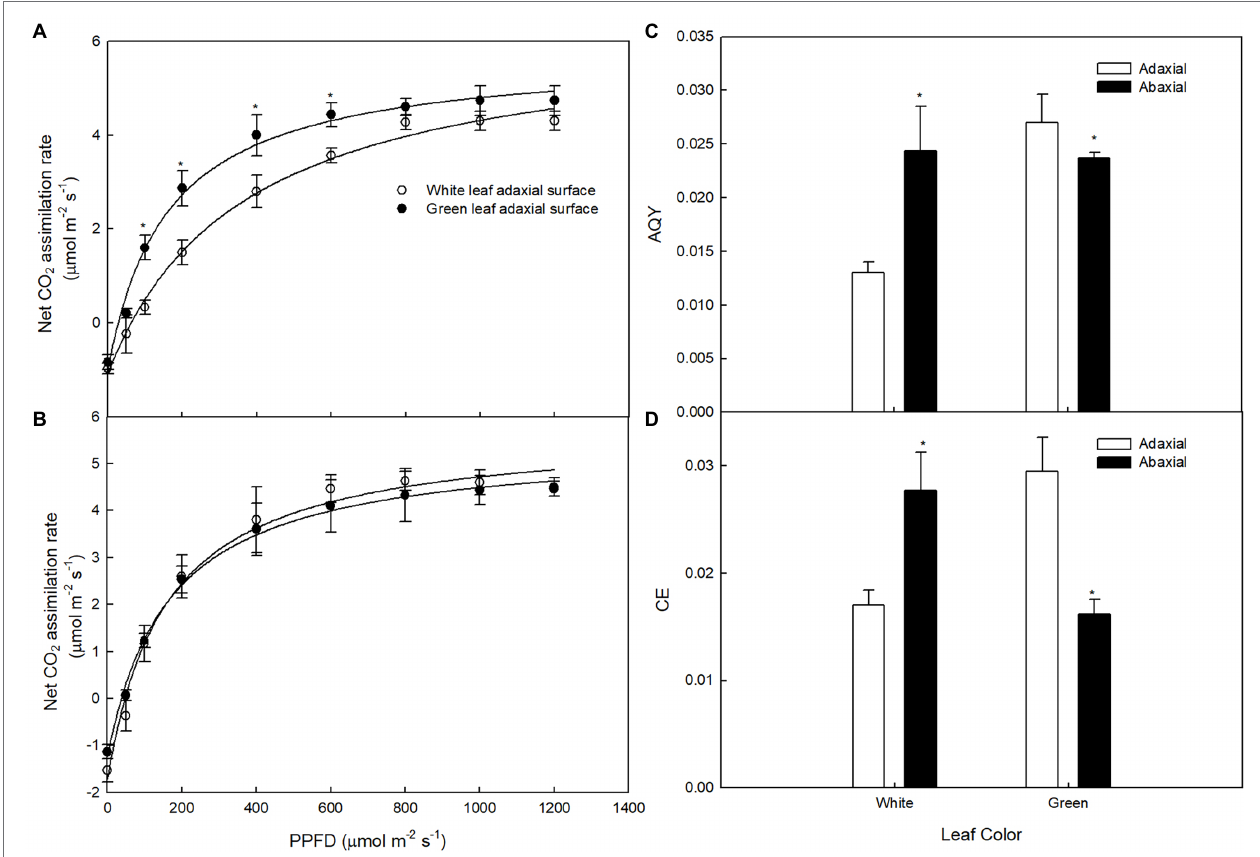
FIGURE 3 | The responses of photosynthesis ( P n ) to photosynthetic photon flux density (PPFD) in white and green leaves P n to PPFD on adaxial surfaces of white and green leaves (A) , P n to PPFD on abaxial surfaces of white and green leaves (B) , AQY on adaxial and abaxial surfaces of white and green leaves (C) , CE on adaxial and abaxial surfaces of white and green leaves (D) Mean ± SE of three replicates are